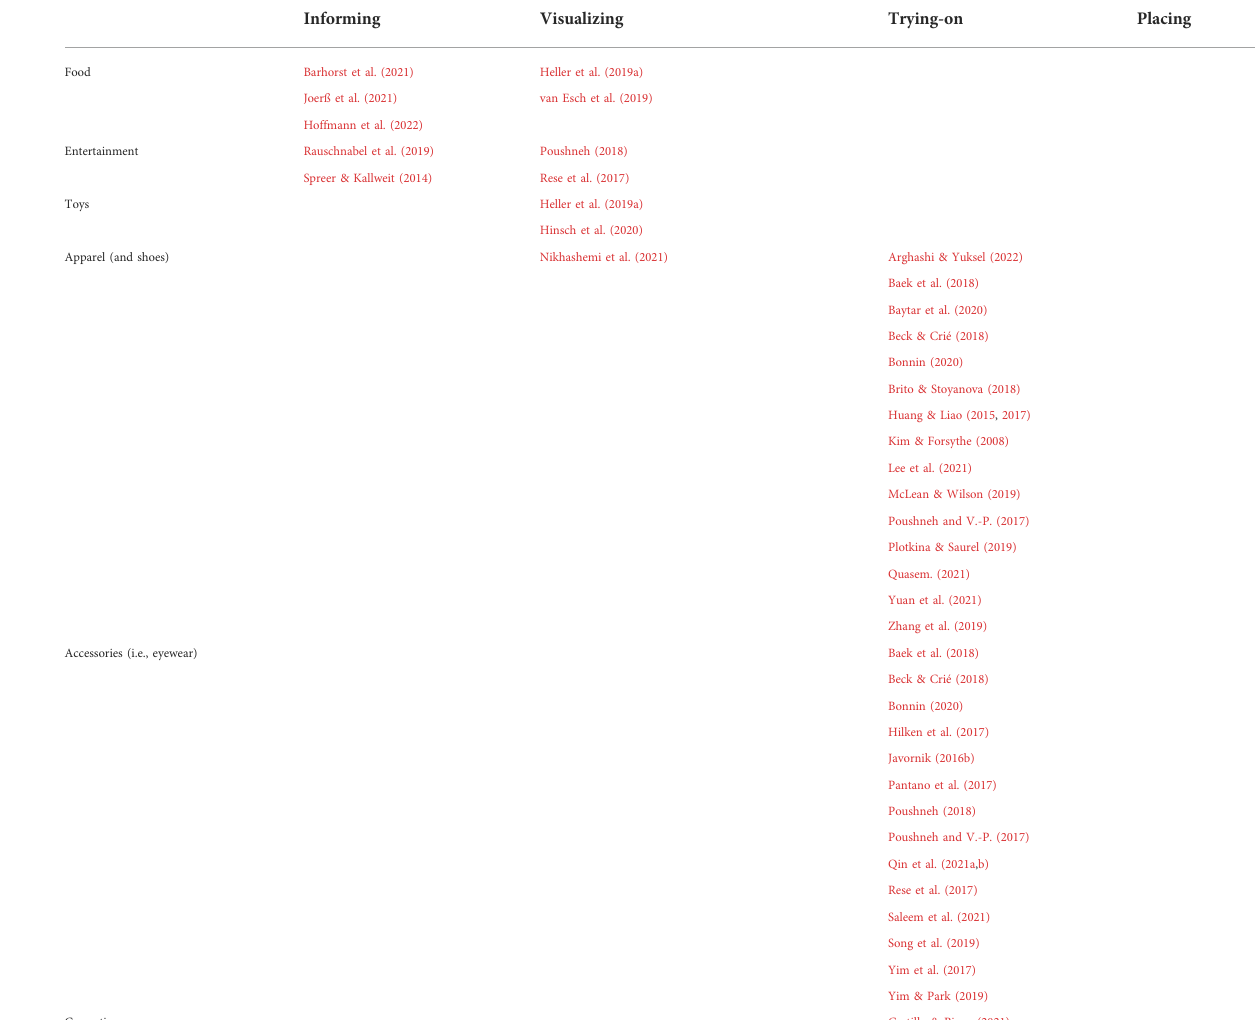
TABLE 3 Product category and AR